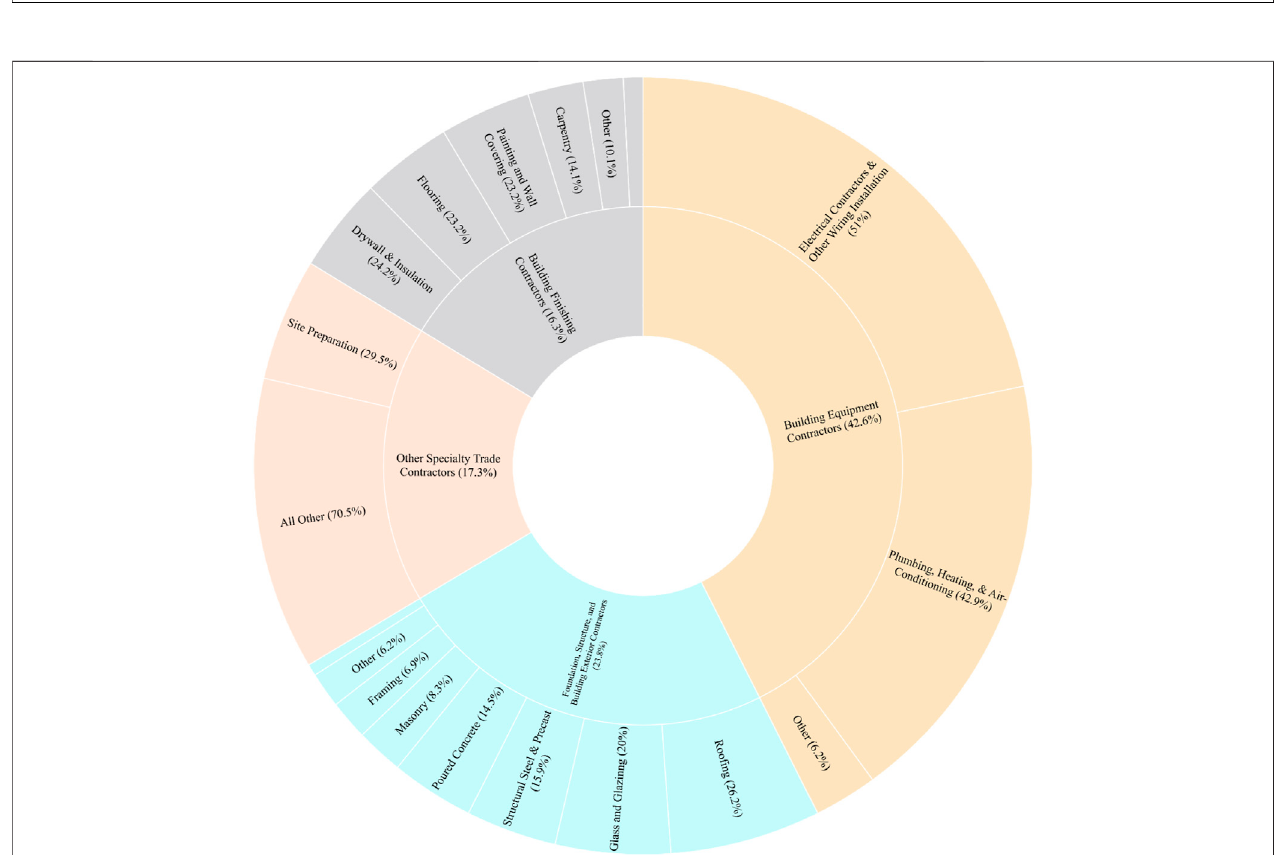
FIGURE 6 | Distribution of “ specialty trade contractor ” complaints.